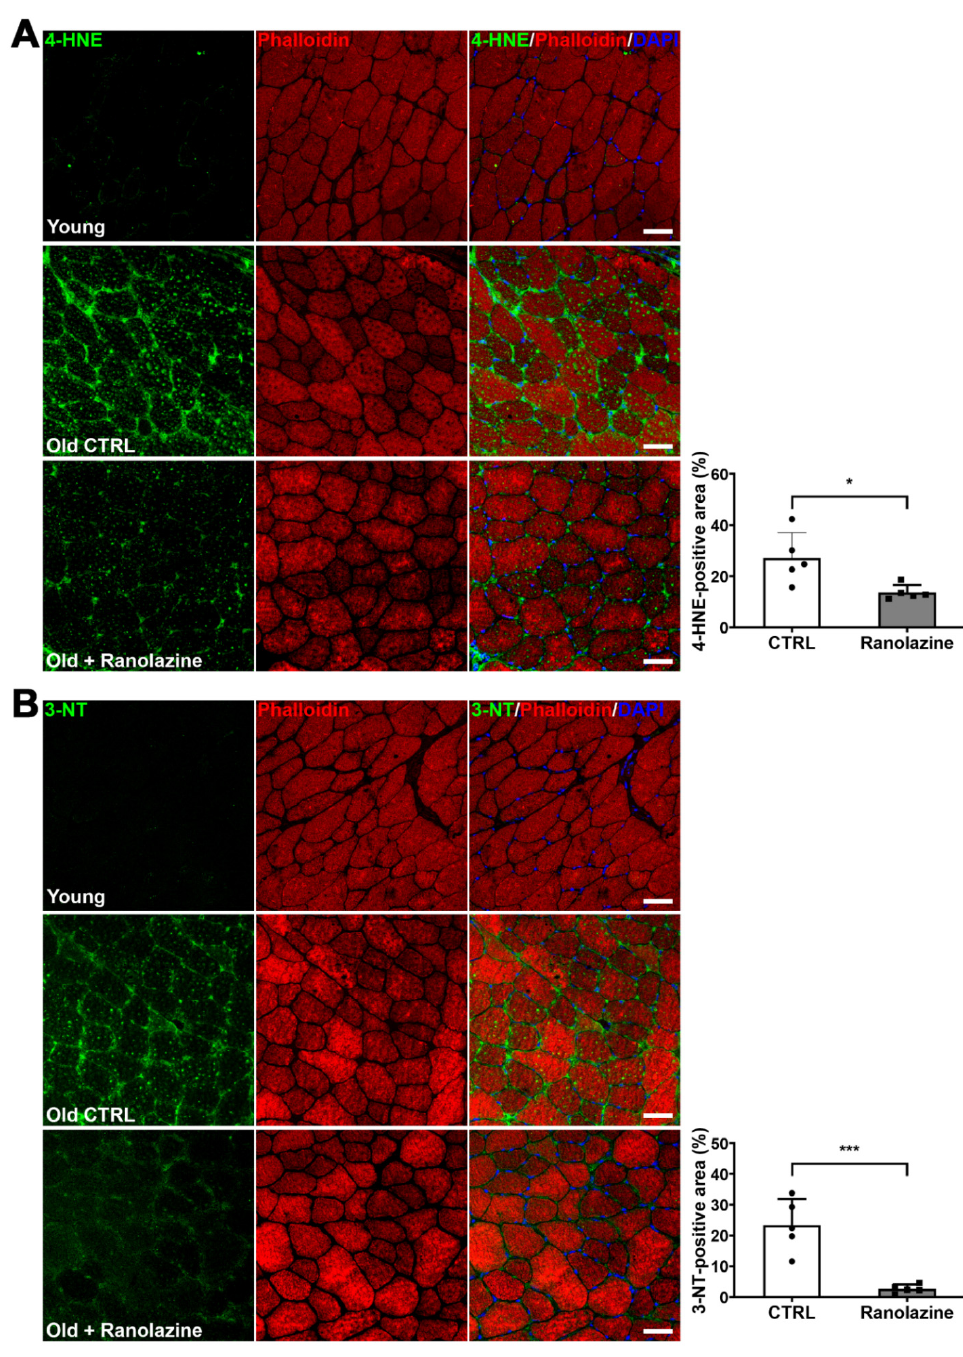
Figure 4. Ranolazine strongly reduces oxidative and nitrosative stress in old sarcopenic mice. ( A ) Rep- resentative images of 8 µ m-thick TA cryosections of young mice and old mice treated or not treated (Old CTRL) with Ranolazine, stained with an anti-4-Hydroxynonenal (4-HNE) antibody (green) and TRITC-conjugated phalloidin (red) to stain the cytoplasm. Nuclei were counterstained with DAPI (blue). Scale bar = 50 µ m. The histogram displays the quantification of the percentage of the 4-HNE-positive area. ( B ) Representative images of 8 µ m-thick TA cryosections of young and old mice treated or not treated (Old CTRL) with Ranolazine, stained with an anti-3-nitrotyrosine (3-NT) antibody (green) and TRITC-conjugated phalloidin (red) to stain cytoplasm. Nuclei were counterstained with DAPI (blue). Scale bar = 50 µ m. The histogram displays the quantification of the percentage of the 3-NT-positive area. Values are means ± SD. n = 5 for both experimental conditions. Unpaired t -test was used for comparison. *** = p < 0.001, * = p <